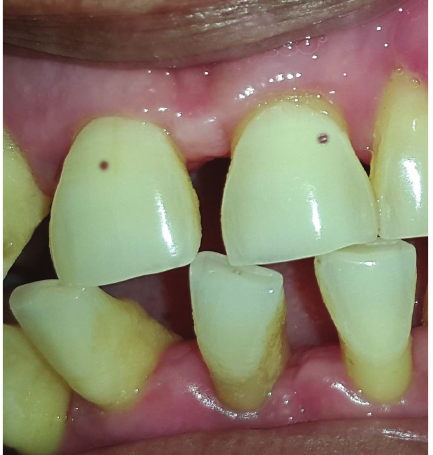
Figure 2: Enamel pitting in upper permanent central incisor region.